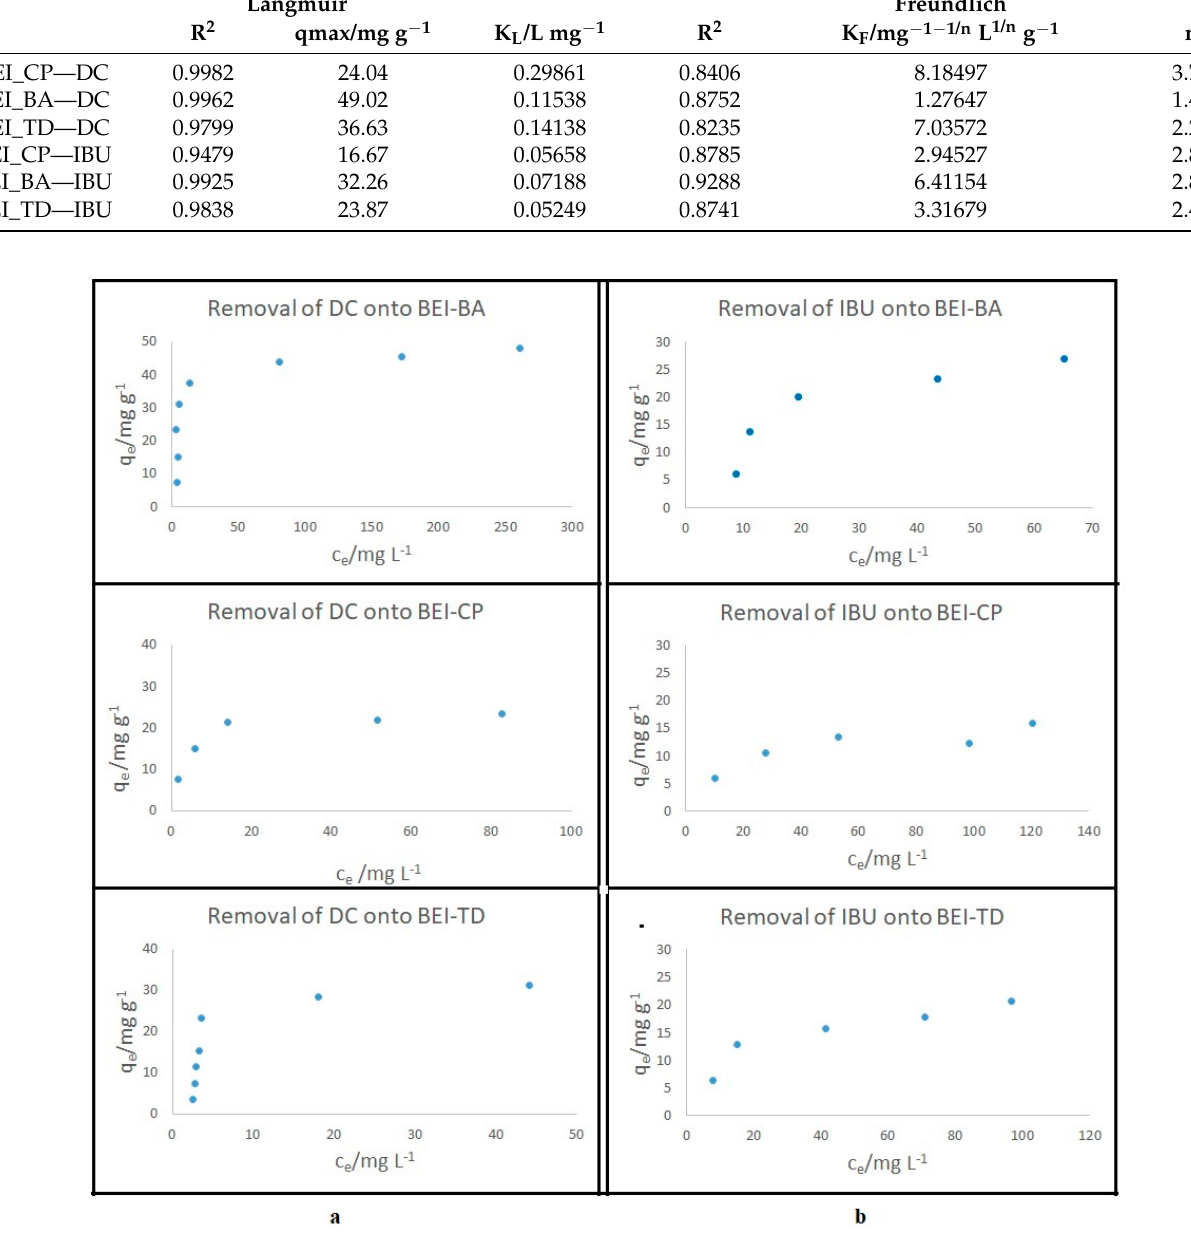
Figure 9. Sorption isotherms ( a ) for DC and ( b ) for IBU.